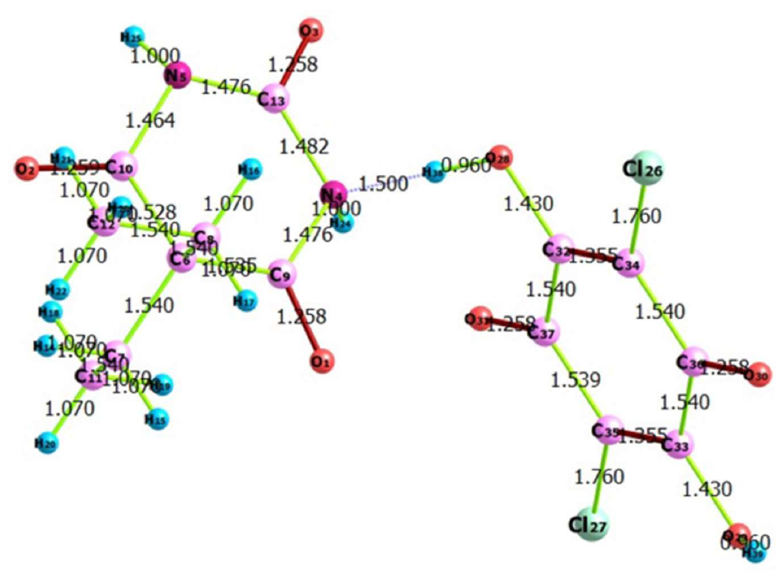
Figure 10. Optimized structure of the (Bar–CLA) complex showing bond lengths. The bond lengths and bond angles are presented in Supplementary Tables S3 and S4.